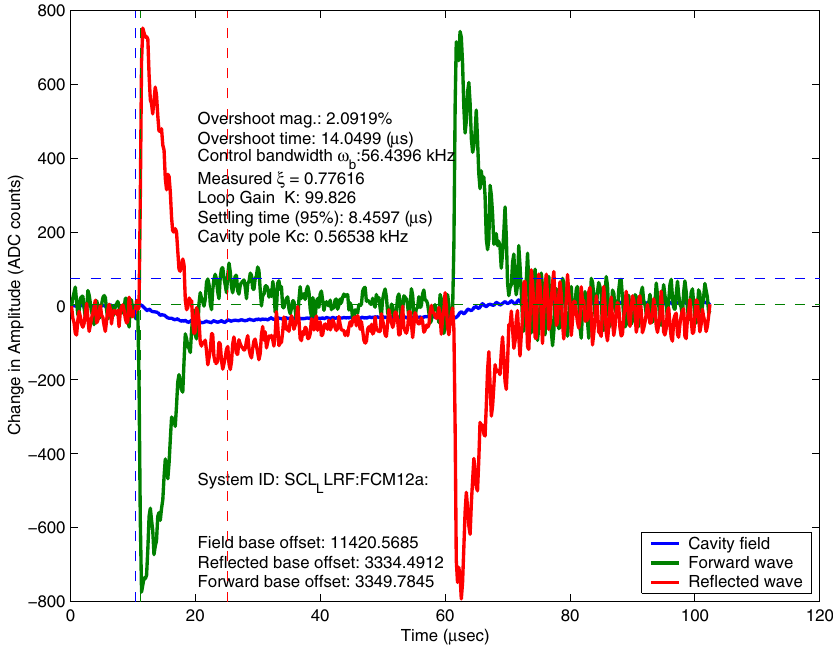
FIG. 7. (Color) A detailed view of the FCM step response measured on superconducting cavity